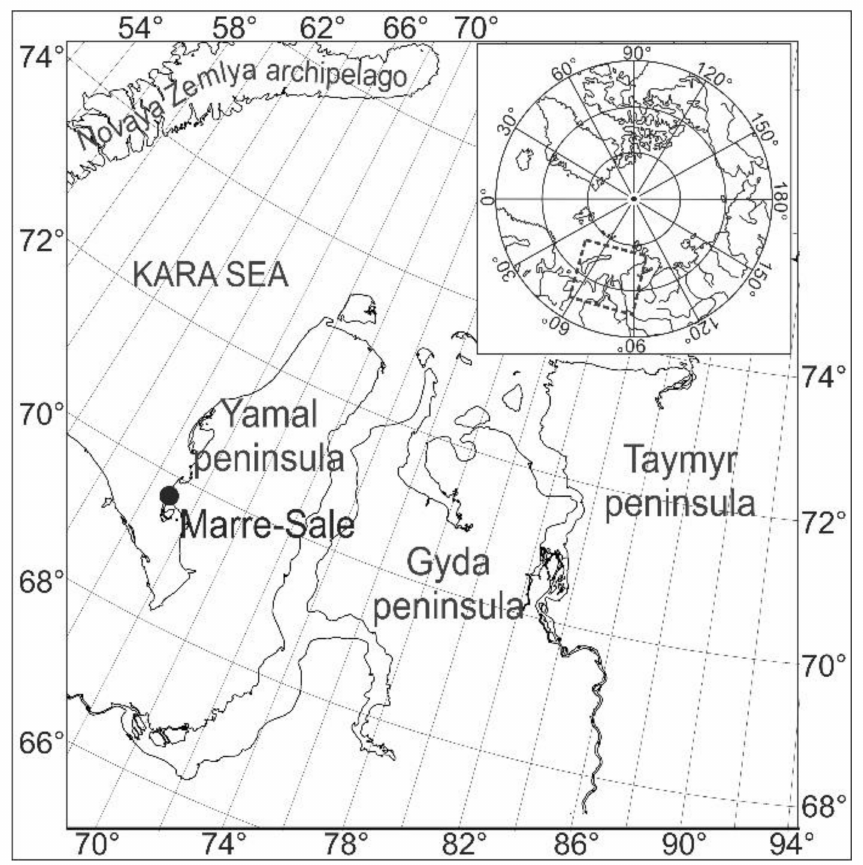
Figure 1. Location of the Marre-Sale study